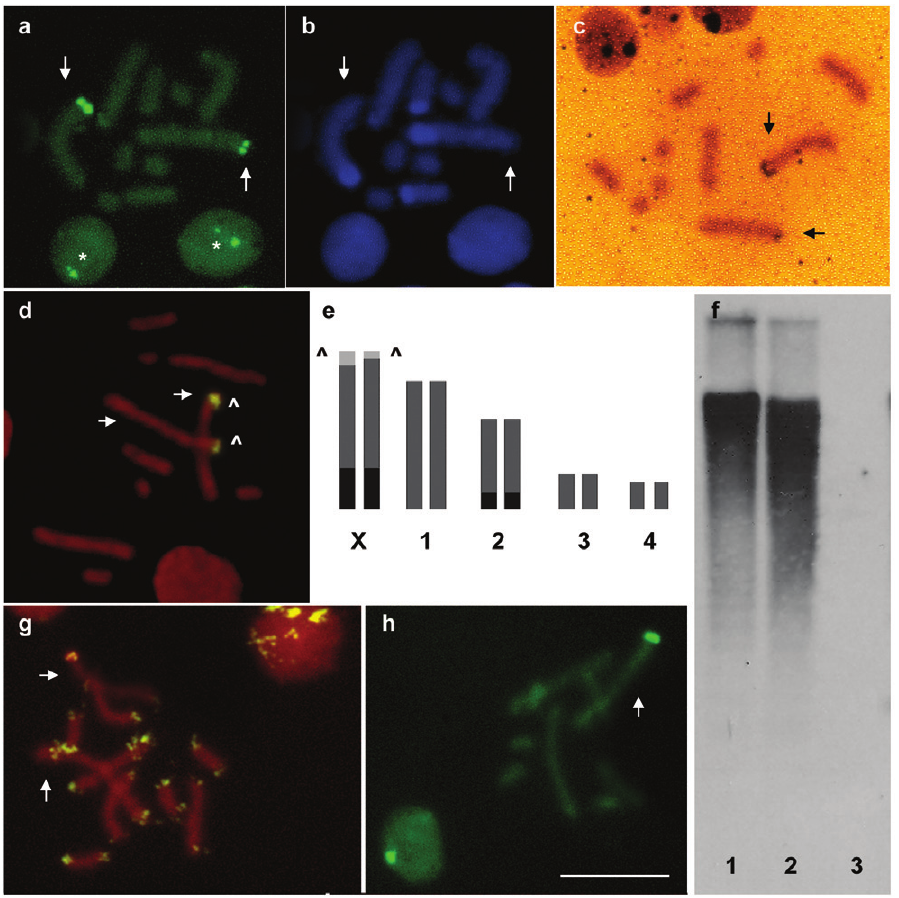
Figure 1a–h. M. euphorbiae chromosomes, stained with CMA (a) and DAPI (b) after C banding, show- 3 ing heterochromatin on one telomere of the two X chromosomes and on autosome pair 2. Silver staining (c) and FISH with a 28S rDNA probe (d) evidenced heteromorphic NORs located at one telomere of each X chromosome that was also fluorescent after CMA staining, as summarized in the panel (e) Southern 3 blotting (f) after digestion with Xho I of DNA samples of A. pisum 1 M. euphorbiae 2 and D. melanogaster 3 together with FISH (g) assessed that the telomeric sequence (TTAGG) constitute each chromosomal n end of the M . euphorbiae chromosomes. CMA staining of male chromosomes showed that all the male 3 plates present the X chromosome with the larger NOR (h) Arrows indicate X chromosomes. Arrowheads indicate NORs. Asterisks evidence the presence of heteromorphic nucleoli in the M. euphorbiae nuclei. Bar = 10 µ